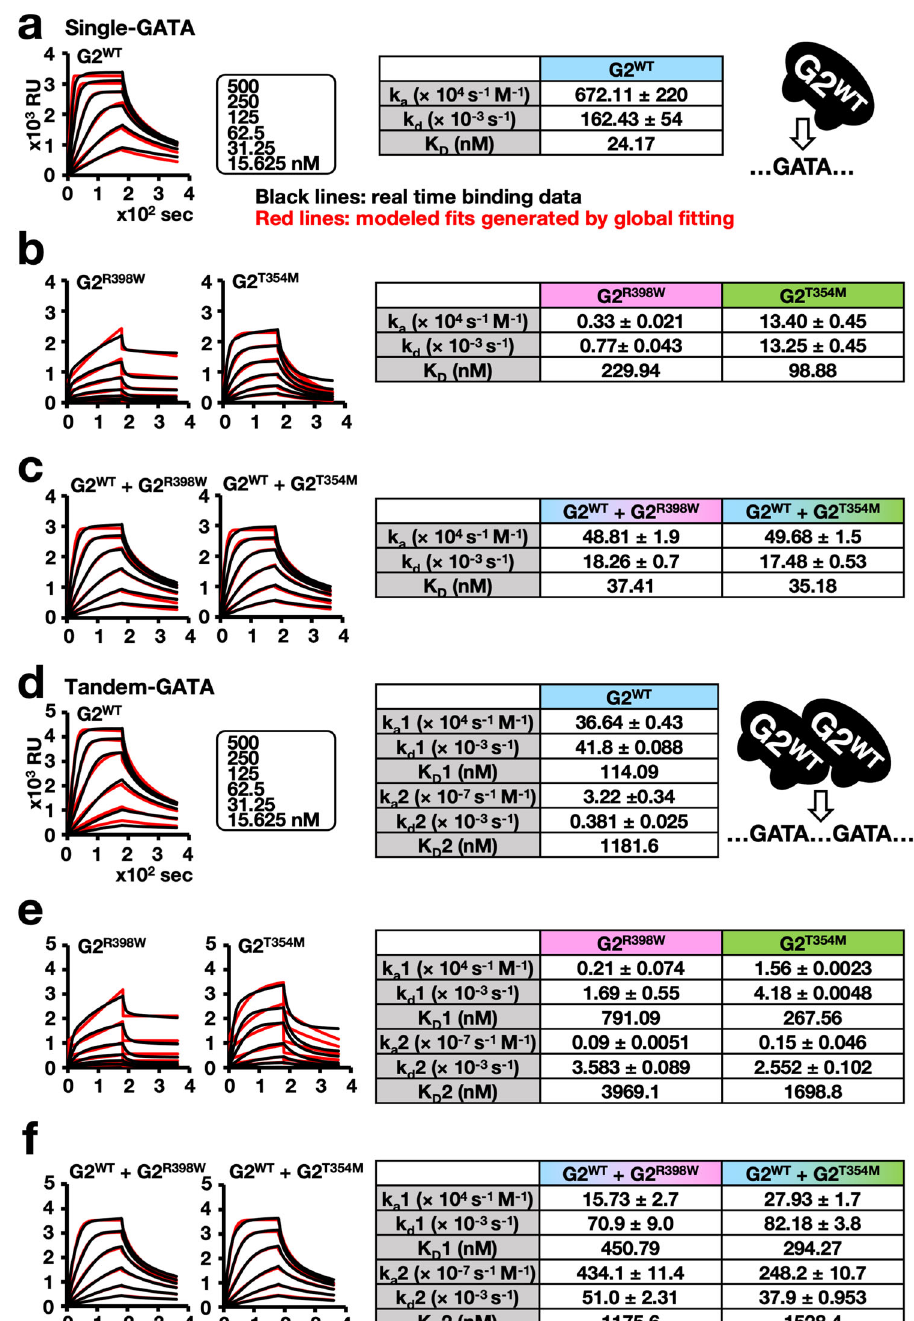
Fig. 7 G2 R398W and G2 T354M disturb G2 WT binding to the tandem GATA motif. SPR analyses of GATA2 binding to single ( a – c ) and tandem ( d – f ) GATA motifs. Schematic diagrams of the binding model of G2 WT to single and tandem GATA motifs are shown on the right in a , d , respectively. The in fl uences of the fl ow rate of the respective GATA2 proteins at the indicated protein concentrations are shown on the left. Kinetic parameters of the respective GATA2 proteins are shown in the tables. A mixture of equal amounts of the G2 WT and G2 mutant proteins was used in c , f . Experiments were performed in duplicate, and the results were